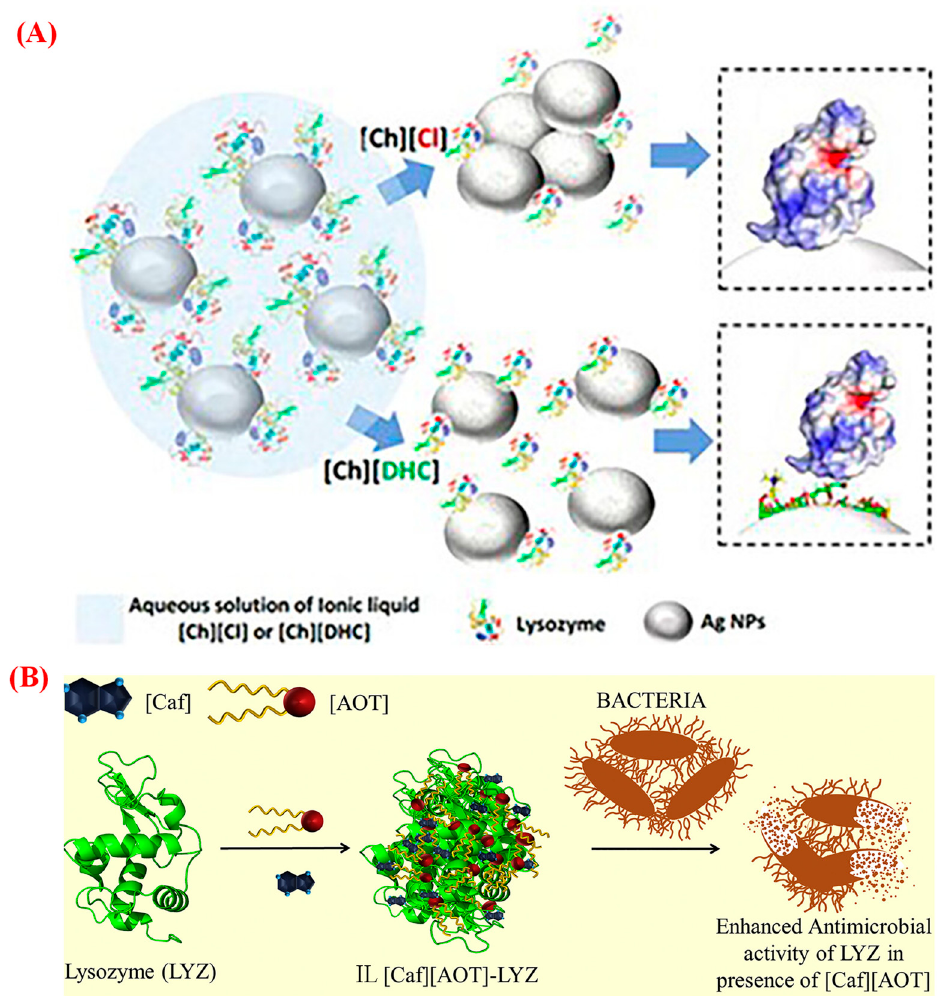
Figure 5. ( A ) Schematic representation of the impact of aqueous choline dihydrogen citrate (IL[Ch][DHC]) and choline chloride (IL[Ch][Cl]) on the protein–silver nanoparticle conjugates. IL[Ch][Cl] containing protein is adsorbed on the surface of nanoparticles, in contrast, the dihy- drogen citrate anions of IL[Ch][DHC] interact with the silver surface with the oxygen atom (shown in the square box) [54]. ( B ) the enhancement of the antimicrobial activity of the lysozyme (LYZ) against Gram-positive and Gram-negative bacteria [56], reproduced with permission from